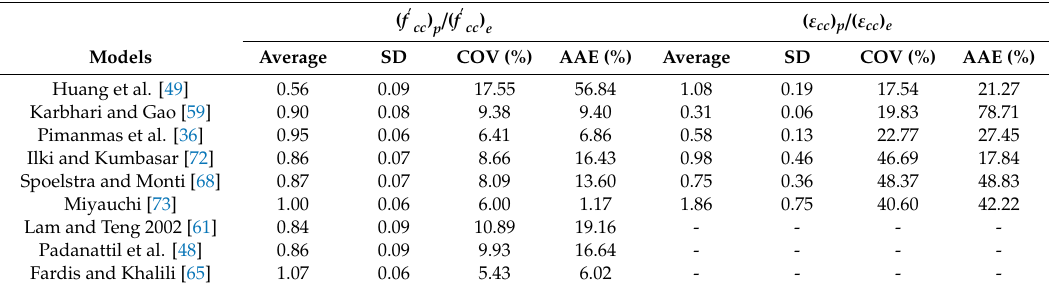
Models Average SD COV (%)